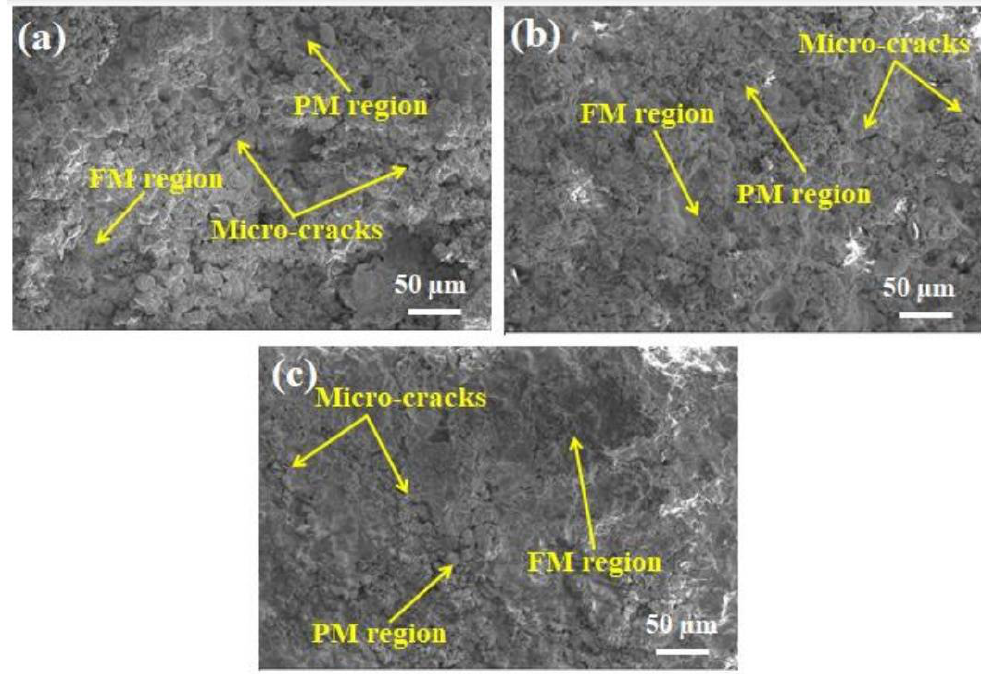
Figure 8. FE-SEM micrograph images of ( a ) NiAl/YSZ, ( b ) NiAl/YSZ/Al 2 O 3 and ( c ) NiAl/YSZ/Al 2 O 3 /CeO 2 , based coating structure exhibiting the micro-cracks, partially melted (PM), fully melted (FM) region [36].